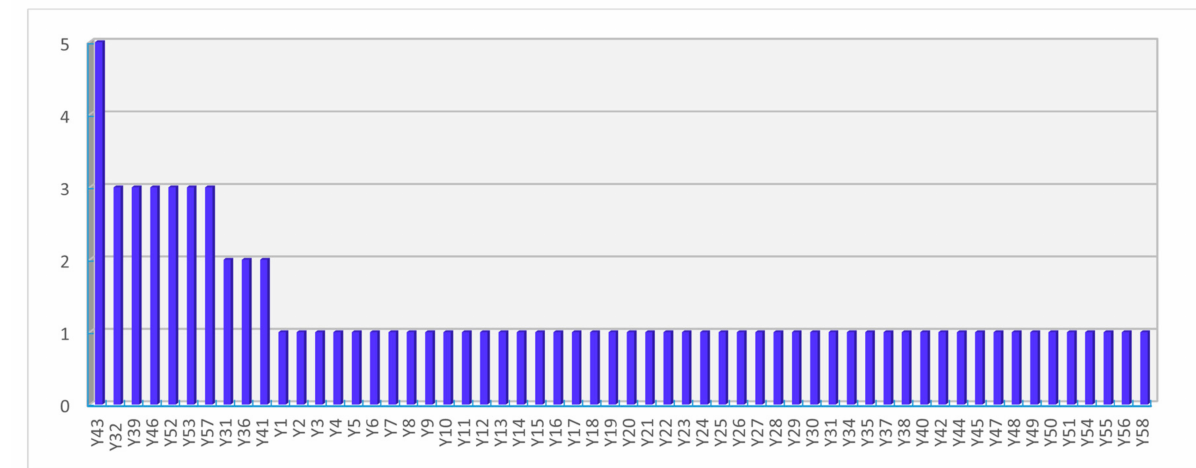
Figure 6. Quality feature node degree